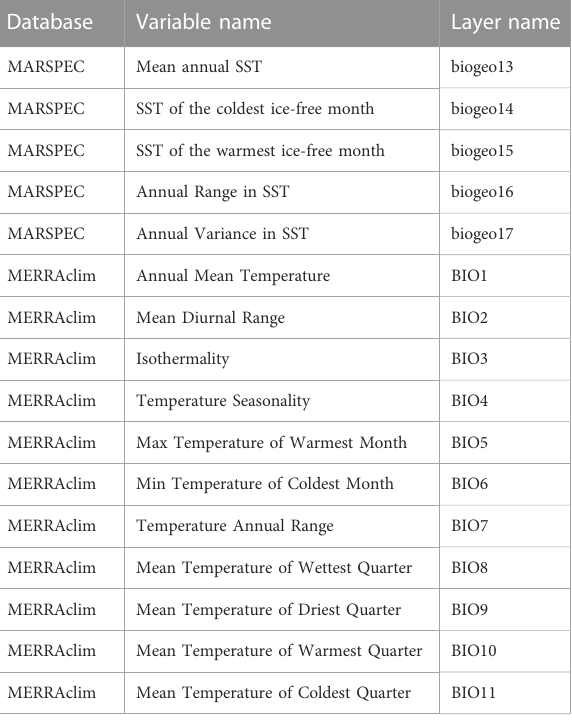
TABLE 1 List of climatic variables and related databases and layer names used for the multiple correlation